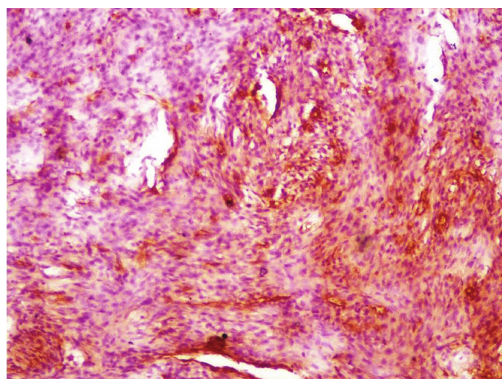
Figure 4: Section showing spindle cells arranged in short fascicles and storiform pattern (10x, H&E) and inset showing tumor cells with oval nuclei, vesicular chromatin, inconspicuous nucleoli, and scanty to moderate cytoplasm (40x, H&E).